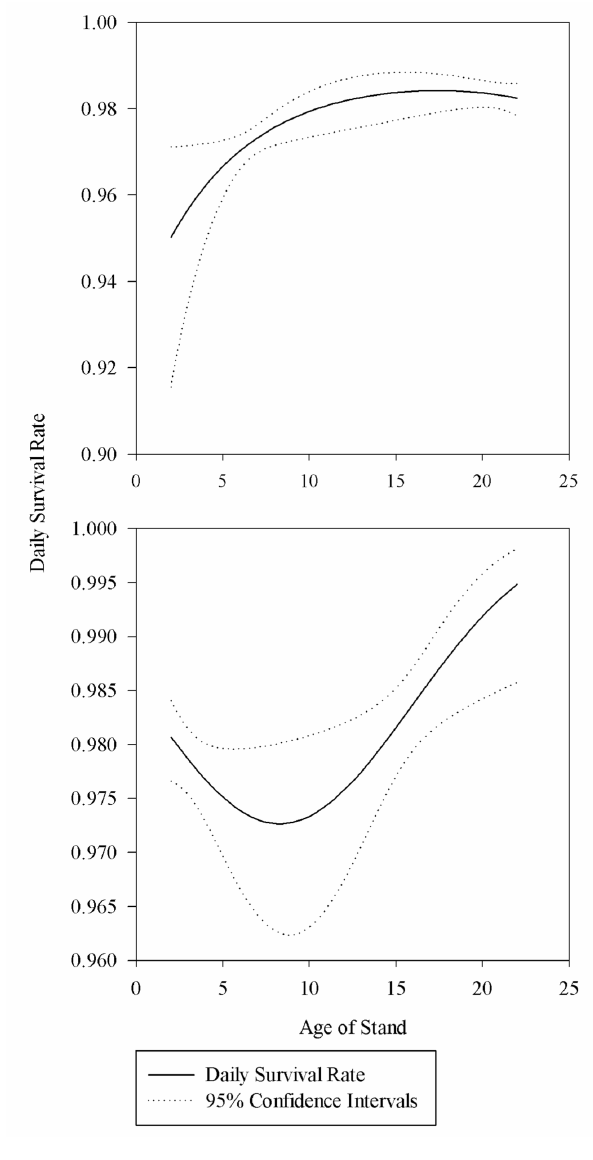
Figure 2. Effect of field age on daily survival rate of nests. Estimated daily survival rate in relation to field age for nests in dense nesting cover (above) and multi-species native plantings (below) from 2010–2011 in the Devils Lake Wetland Management District, North Dakota.